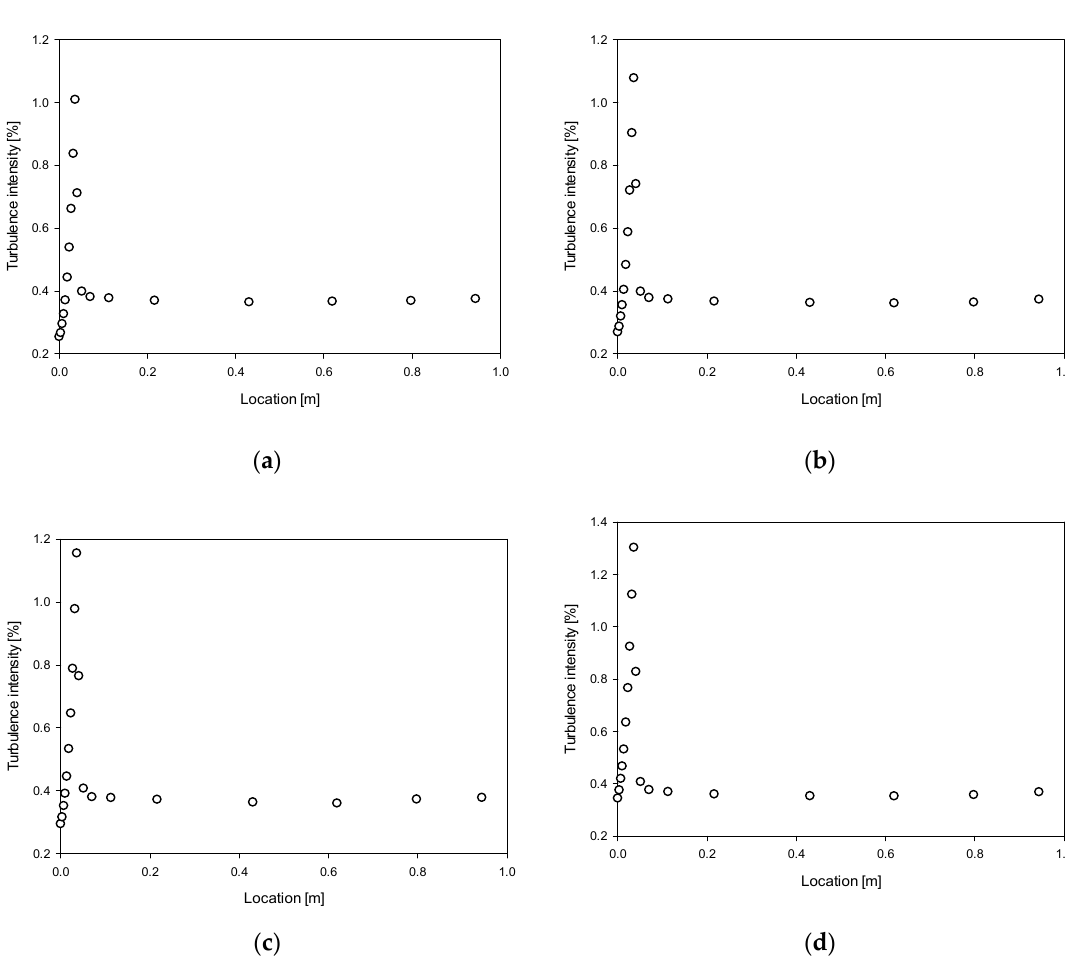
Figure 5. The turbulence intensities obtained by realizable k − ε model at di ff erent times: ( a ) 150 s, ( b ) 250 s, ( c ) 350 s, ( d ) 500 s (Location 0: discharging point).